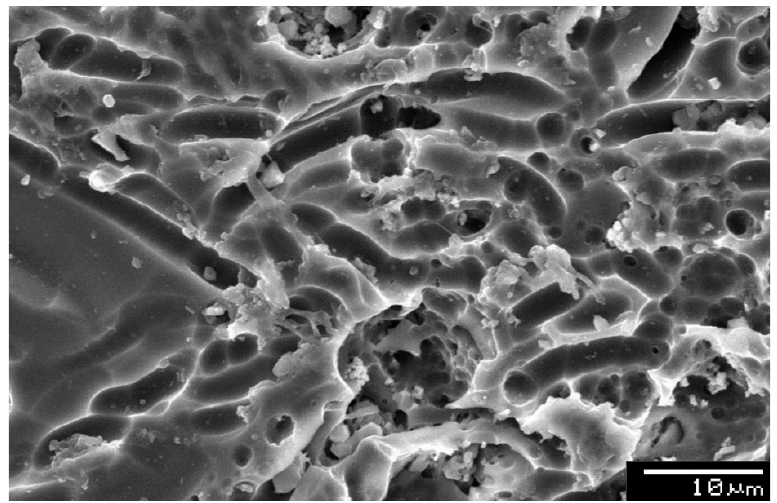
Figure 1. Group A: etching effect of hydrofluoric acid on the ceramic surface at ×2000 under SEM.